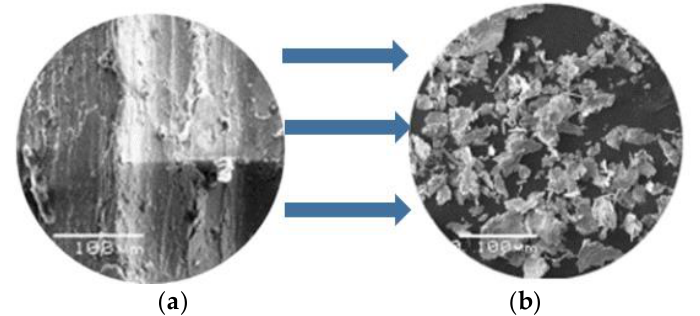
Figure 4. Microscopic observation of the ( a ) grooved surface and ( b ) chips. The diamond grits on the diamond beads are artificial. According to the diamond beads observed by SEM in Figures 2 and 3, the diamond grits have a relatively regular octahedral hexakis shape, and more than 70% of them are wrapped. The prism